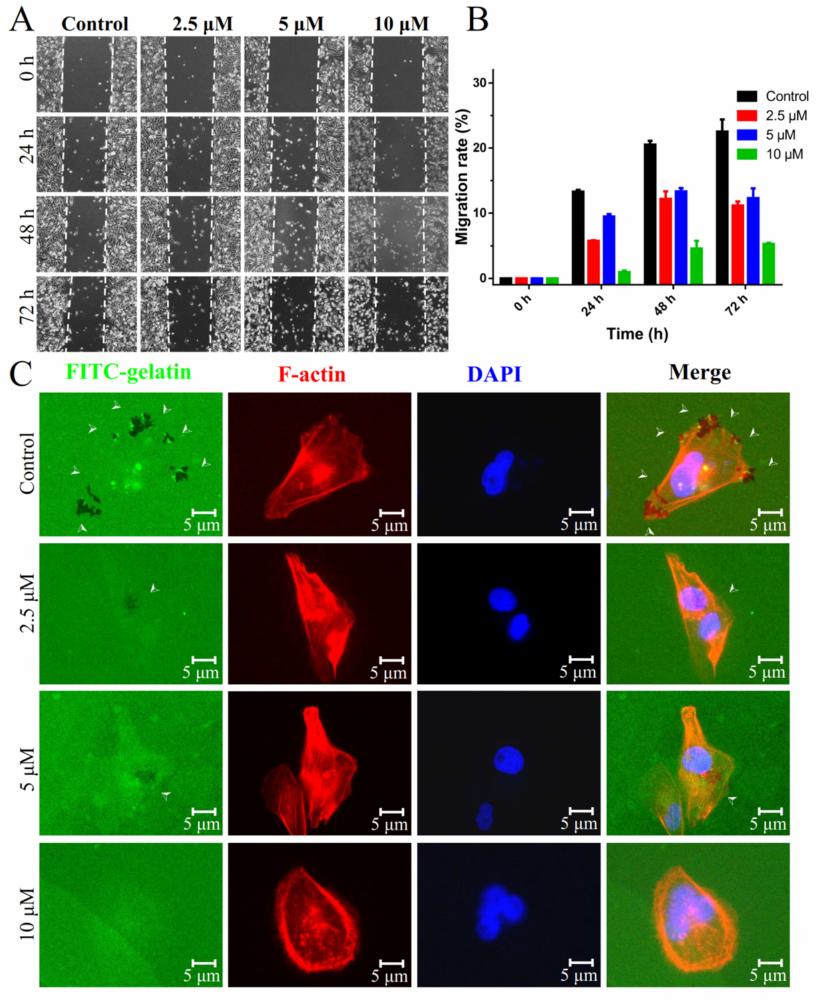
Figure 5. Migration and invasion of MDA-MB-231 cells blocked by ∆ − 3 in vitro. ( A ) Wound-healing assay to assess the migration of MDA-MB-231 cells induced by ∆ − 3 (0, 2.5, 5, and 10 µ M) and DMEM without FBS. The pictures were captured by using a microscope every 24 h.( B ) Wound-healing rate of MDA-MB-231 cells treated with ∆ − 3 (0, 2.5, 5, and 10 µ M) (N = 3). ( C ) The FITC–gelatine assay to evaluate the invasive ability of MDA-MB-231 cells was suppressed by ∆ − 3 (0, 2.5, 5, and 10 µ M). Data were plotted as means ± SEM. Statistical significance was assessed using one-way ANOVA. Values versus the control group: * p < 0.05; ** p < 0.01; *** p < 0.001. ns: no